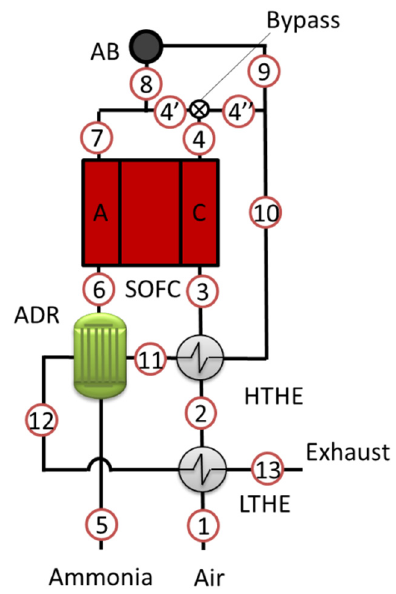
Figure 3. Scheme of the SOFC-NH 3 system.